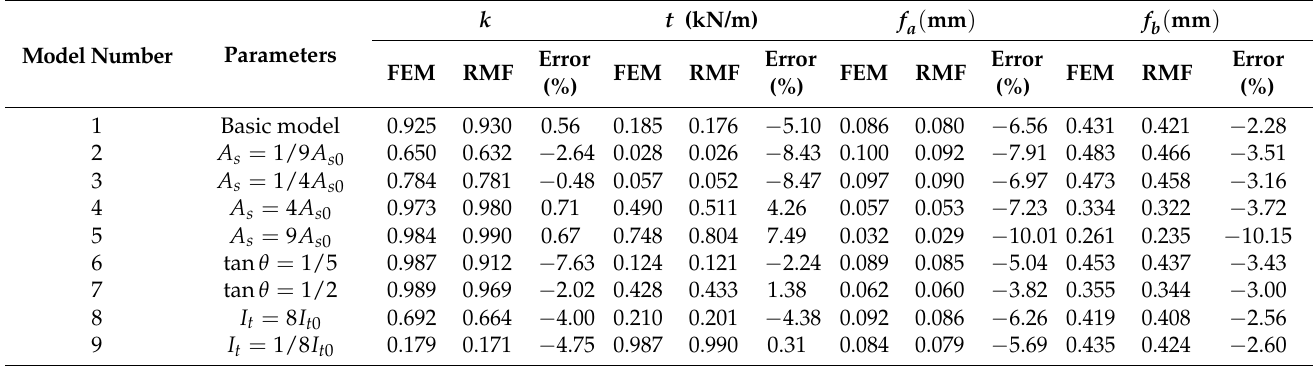
Table 2. Comparison of the finite element method (FEM) and Ritz method formulas